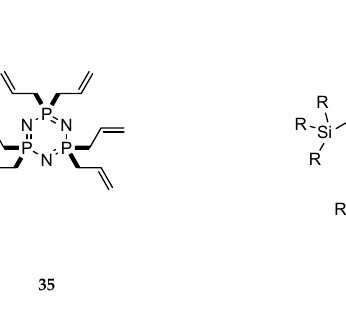
Figure 14. Chemical structures of 35 and 36 .